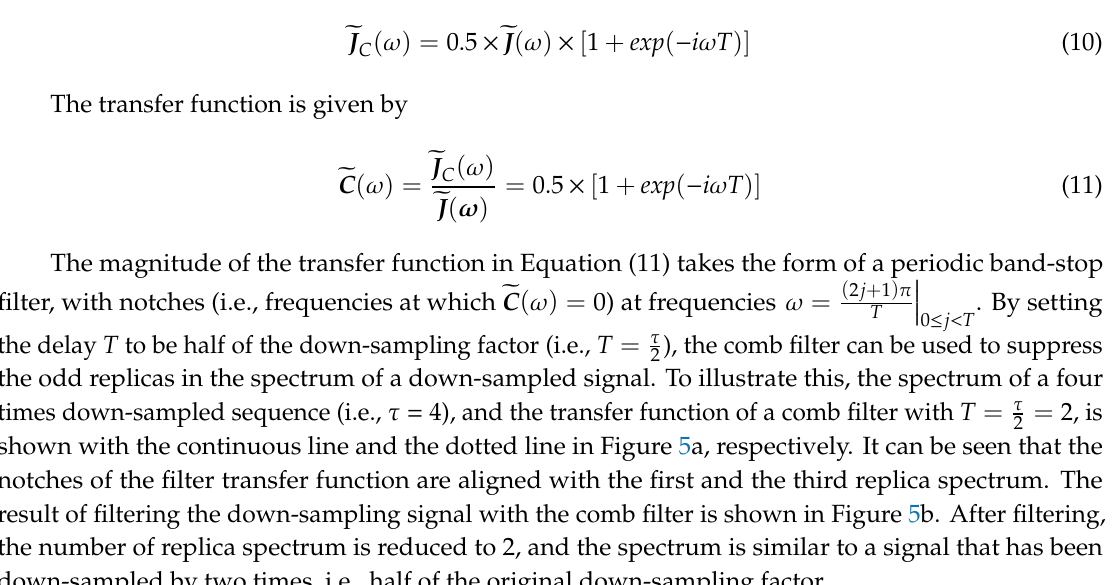
Figure 4. Proposed method for enhancing the reconstructed image of a SPOH with time-division comb filtering.